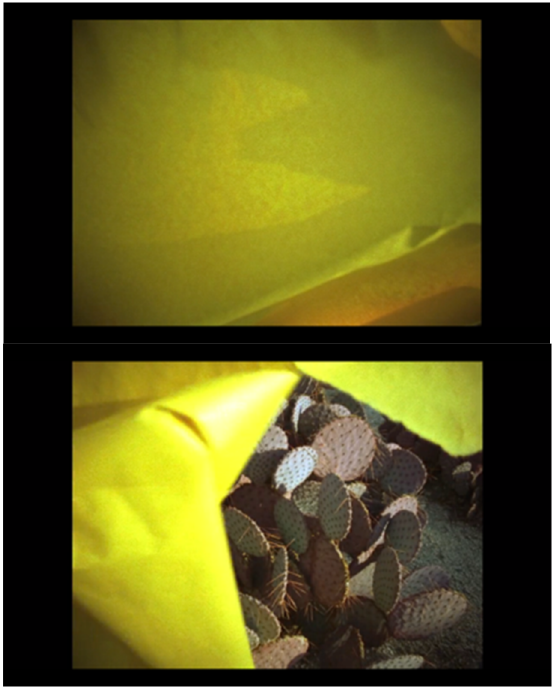
Figure 6. Live to Live (2015).